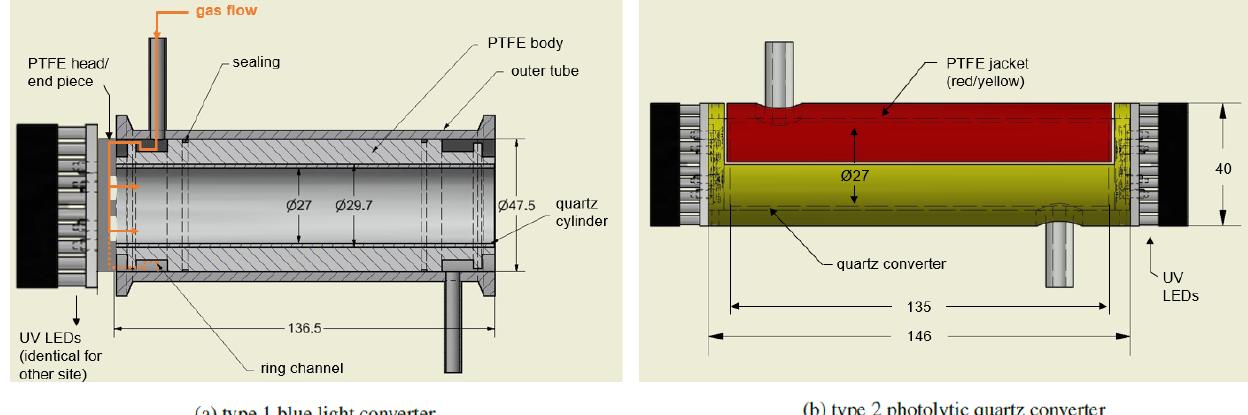
Figure 1. Sketches of the photolytic converters applied in this study.